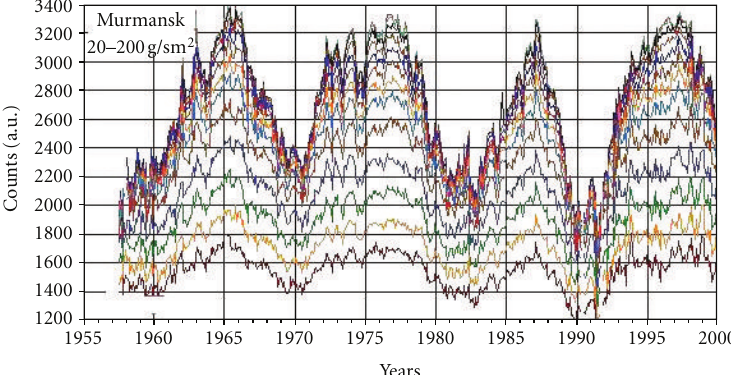
Figure 12: Temporal profile of cosmic ray intensity measured over Murmansk since 1957 at different depths of the atmosphere [44, 45].